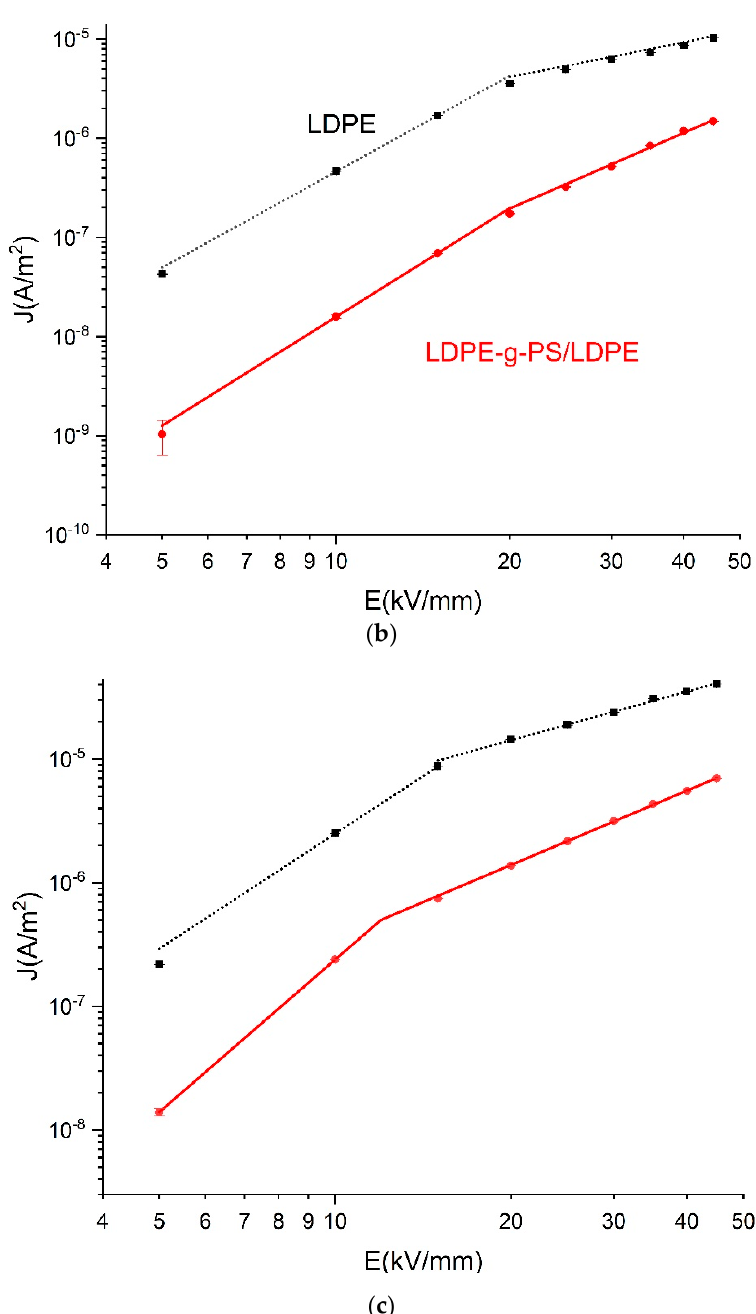
Figure 8. E–J plots of LDPE and LDPE-g-PS/LDPE at 30 °C ( a ), 50 °C ( b ), and 70 °C ( c ).